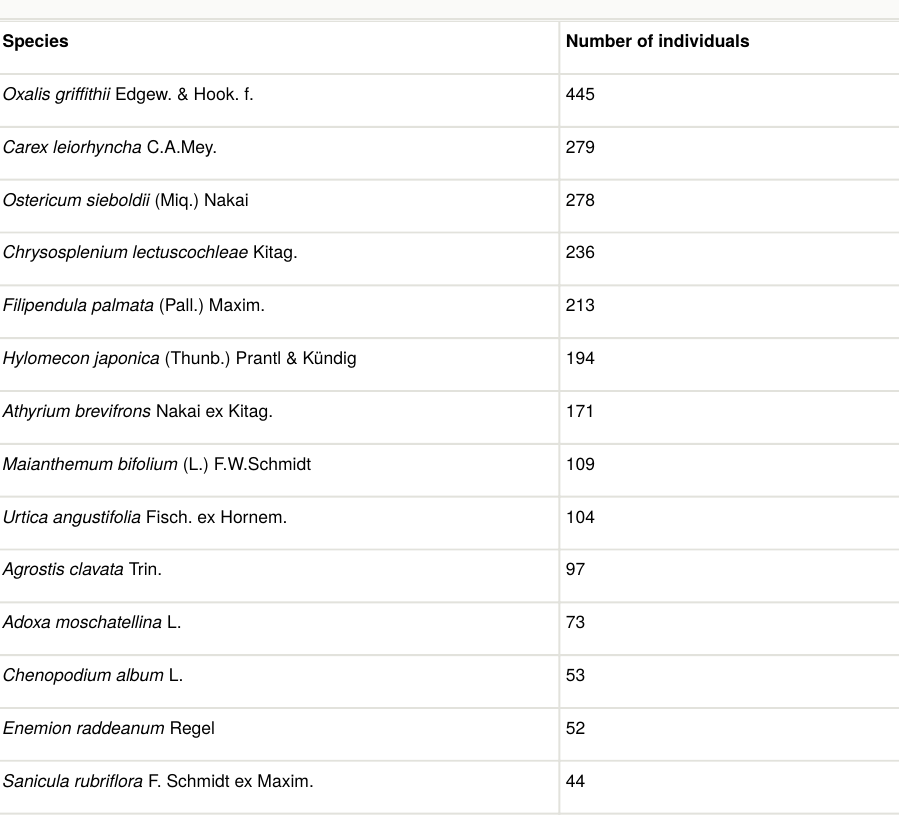
Table 9. The number of individuals in each species of herb in Liangshui National Natural